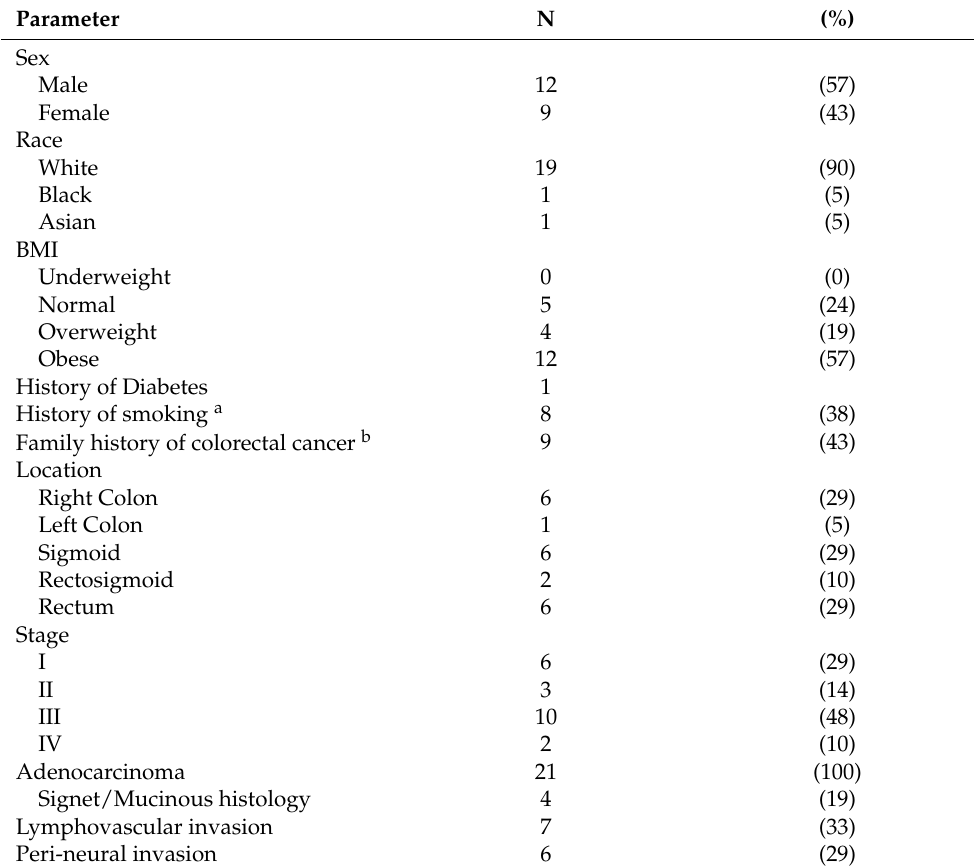
Table 1. Patient